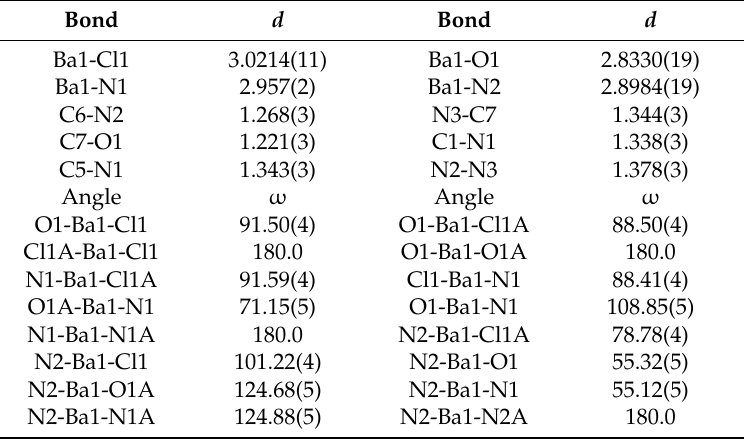
Table 1. Selected bond lengths (Å) and bond angles ( ◦ ) for Ba(II)